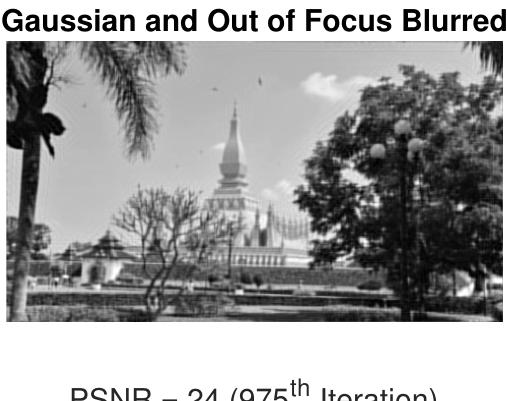
Figure 39. The reconstructed grey image of all cases using the proposed method (2) with PSNR =